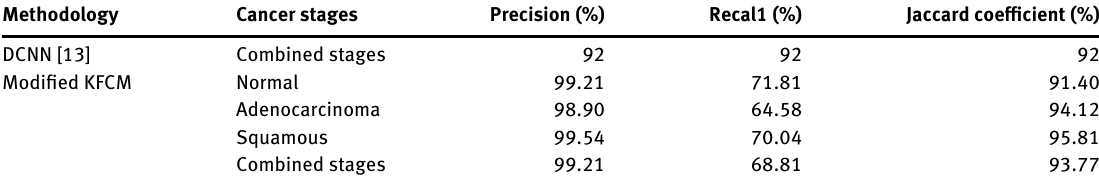
Table 4: Performance comparison of the proposed and existing approach by means of precision, recall, and Jaccard coeflcient.